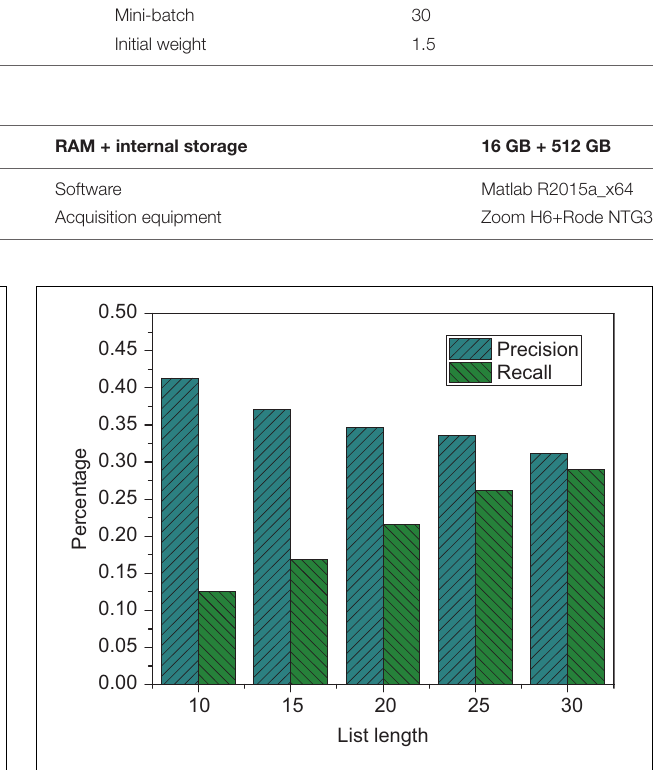
FIGURE 4 | The recommendation results under different list length.